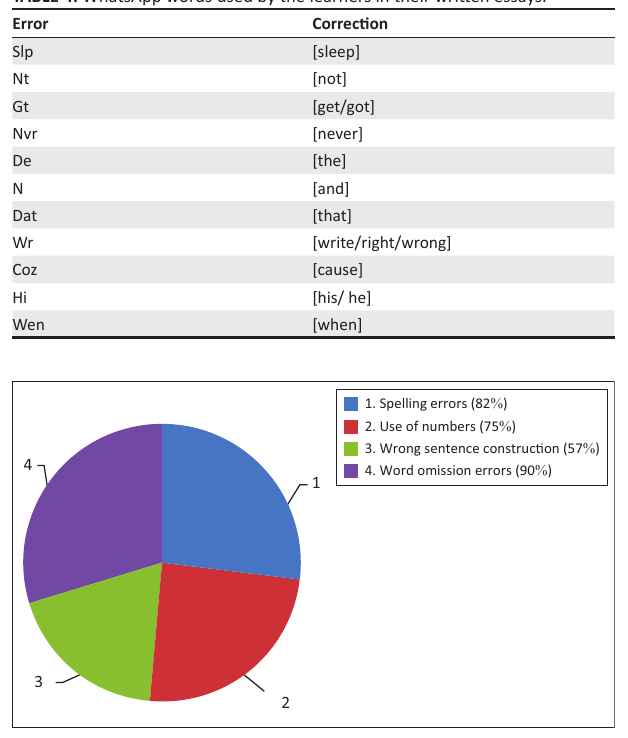
FIGURE 1: Types of predominant orthographic errors frequency.